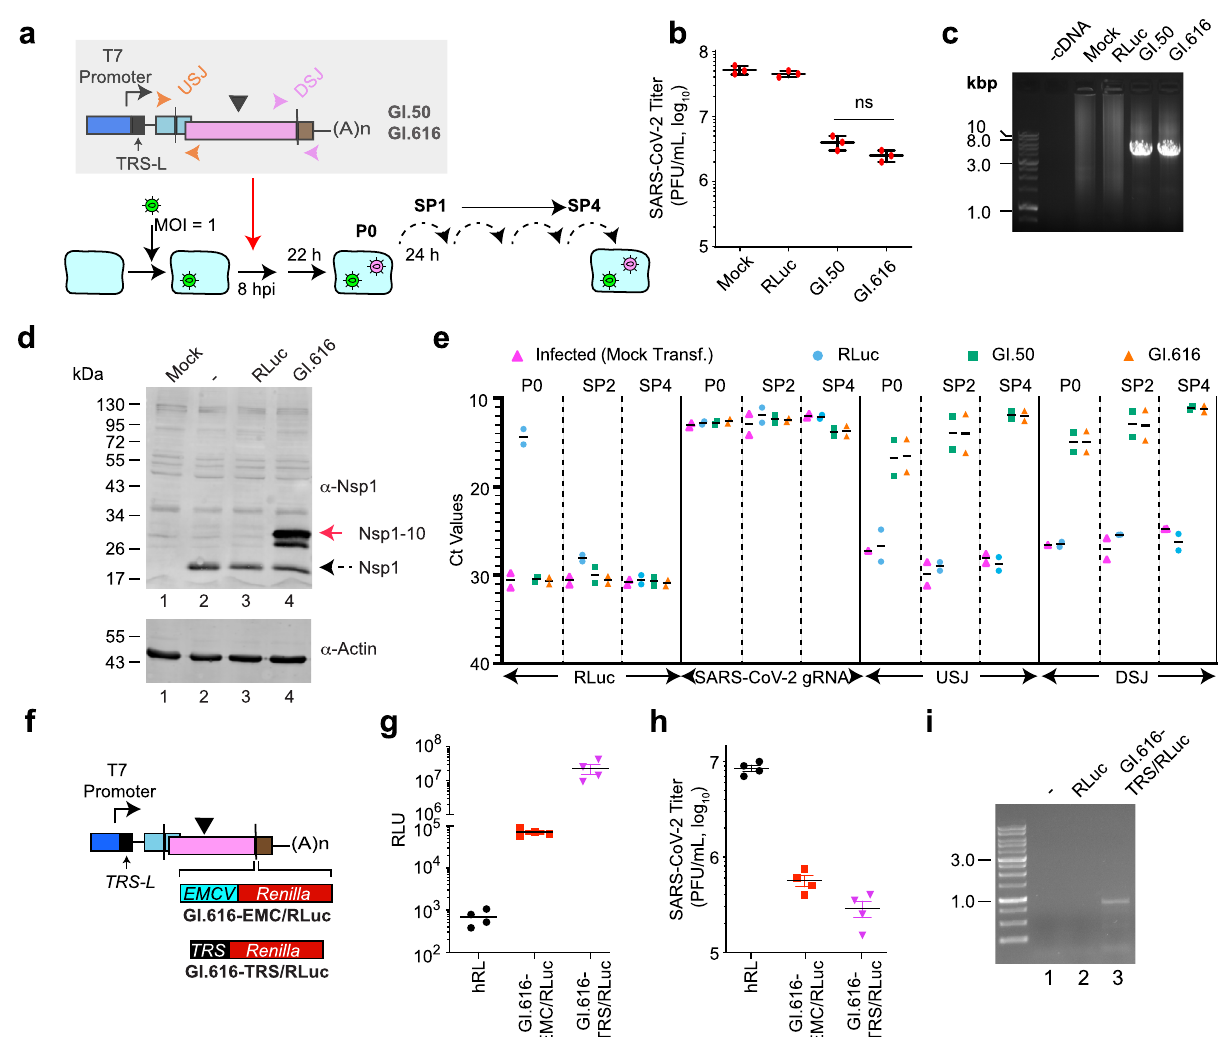
Fig. 3 Characterization of synthetic DI genomes. a Experimental fl ow used to generate synthetic DI particles. Following infection of Vero E6 cells with SARS-CoV-2 at an MOI = 1, cells were transfected with in vitro synthesized RLuc, GI.50, or GI.616 RNA. Media was collected 22 h later, clari fi ed, and used in serial infections (four passages) of Vero E6 cells. b Quantitation of virus titers obtained from the indicated DIs at SP4. n = 3 biologically independent experiments ± SD. ns nonsigni fi cant — p > 0.9 (two-way ANOVA). c RT/LR-PCR showing recovery of DI genomes from SP4-infected cells. d Western blot of extracts probed with α -Nsp1 or α -actin antibodies. Lysates analyzed were prepared from uninfected (mock) Vero E6 cells (lane 1) or Vero cells receiving SP2 from untransfected cells ( − ) (lane 2), RLuc mRNA-transfected cells (lane 3), or GI.616 RNA-transfected cells (lane 4). Dotted arrow denotes Nsp1 and red arrow denotes Nsp1 – 10 fusion. e RT-qPCR analysis of RNA from P0, SP2-, and SP4-infected cells. RNAs targeted by each oligo pair is shown on the bottom. Obtained Ct values are displayed. n = 2 biologically independent experiments, black bar represents the mean. f Schematic diagram of DI genomes harboring EMCV/RLuc or TRS/RLuc expression cassettes. g RLuc activity obtained from the indicated constructs at SP4. n = 4 biologically